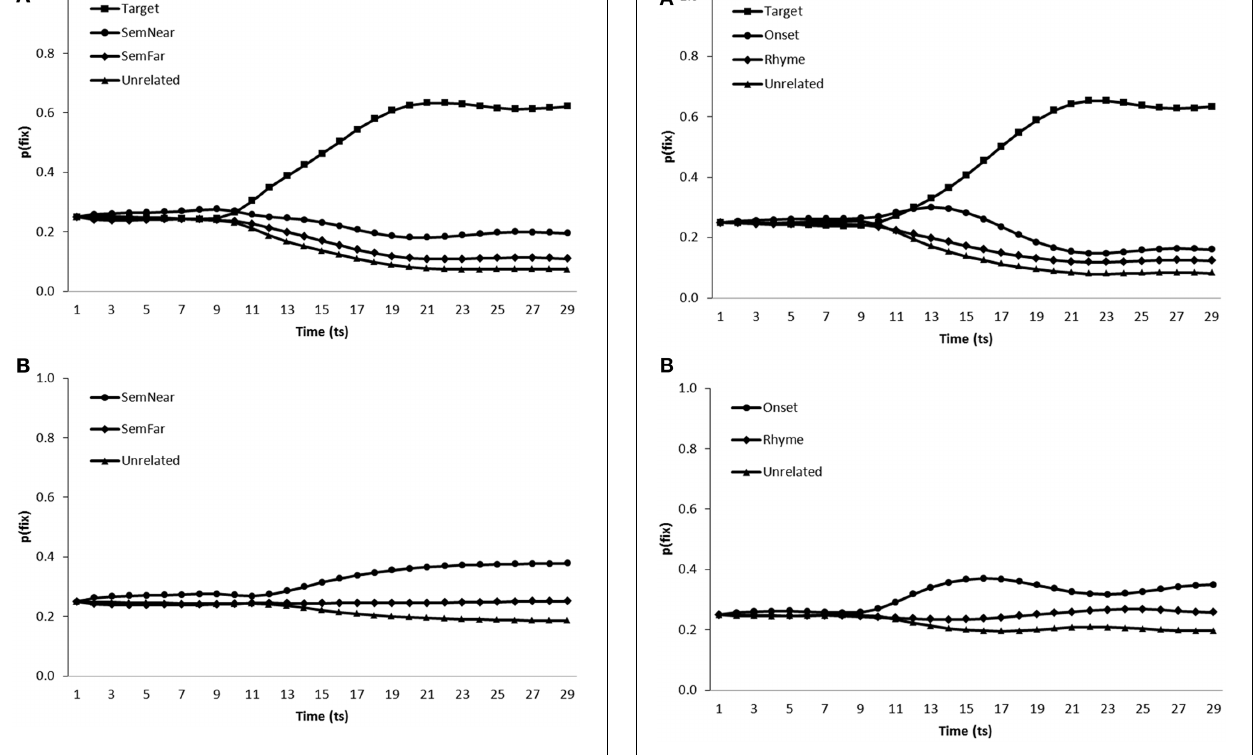
FIGURE 8 | Proportion of fixations [p(fix)] directed toward items within scenes containing (A) a target, an onset competitor, a rhyme competitor and an unrelated distractor, (B) an onset competitor, a rhyme competitor and two unrelated distractors; by the model trained in a noisy learning